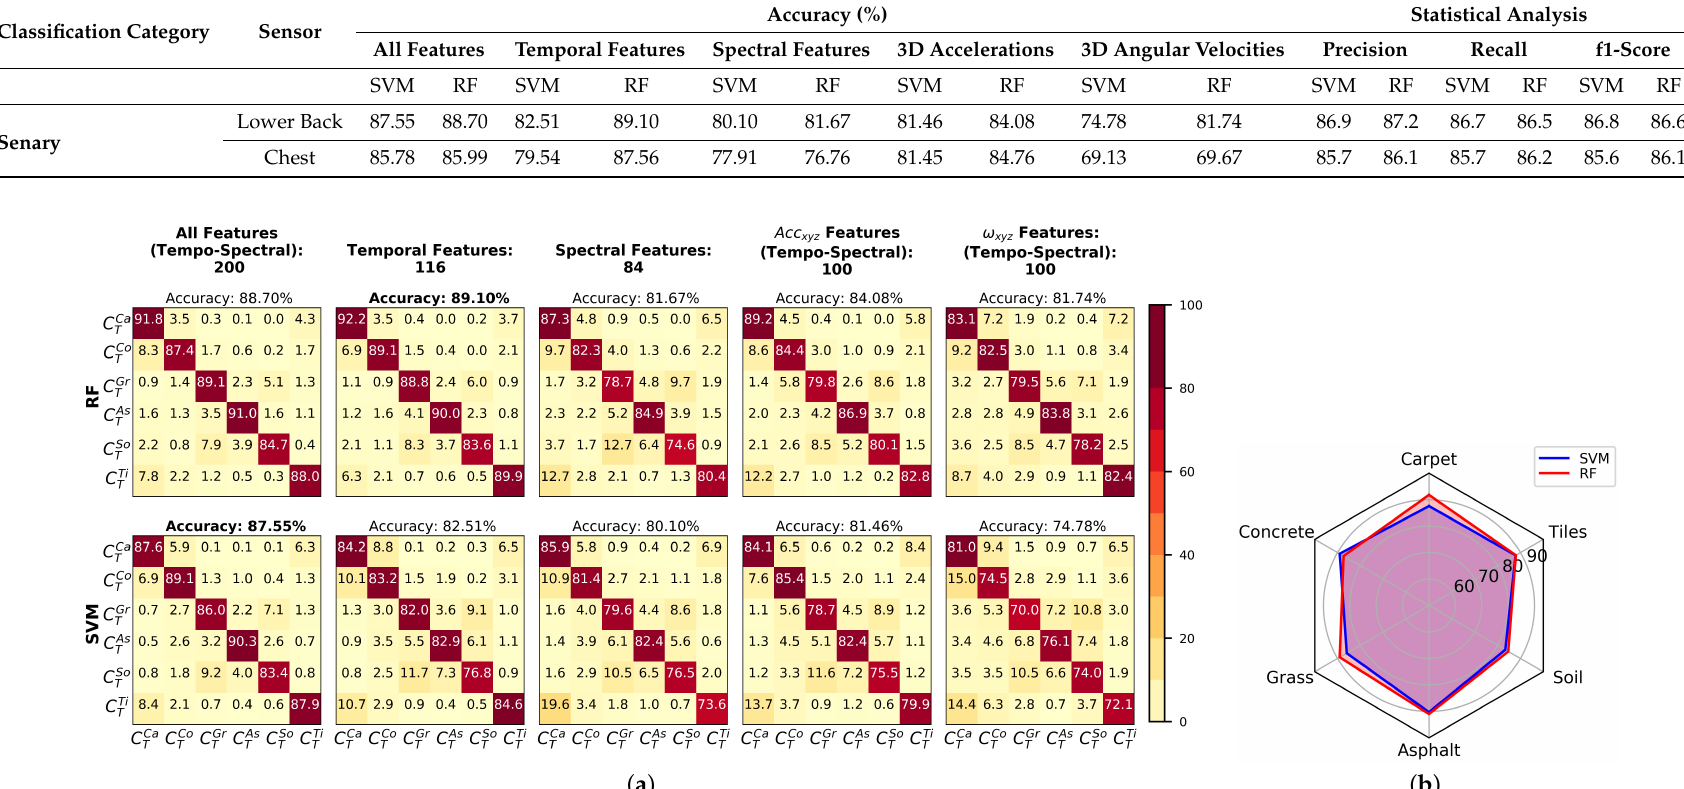
Table 7. Classification results of quinary and senary classification for each sensor location. The classification results are presented for each feature set and statistical scores are presented for the set of all features only.